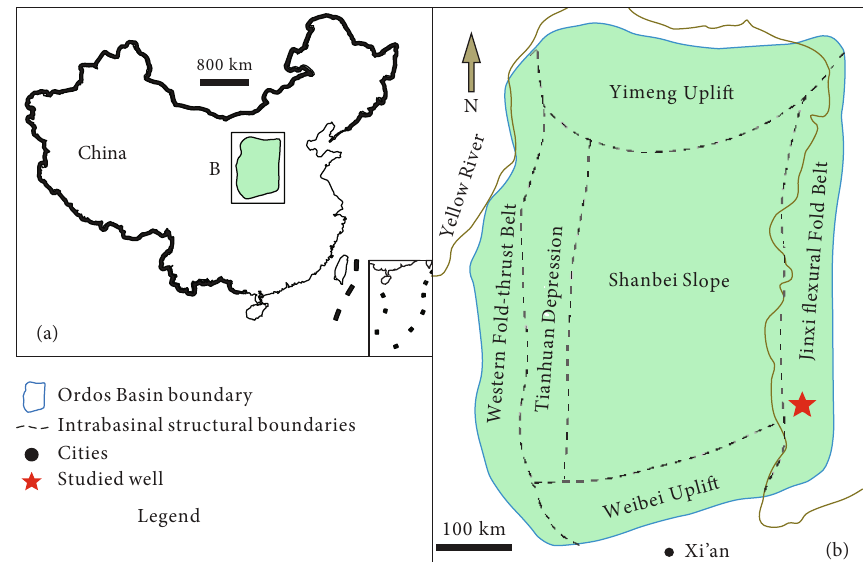
Figure 1: Location map of the study area in the Ordos Basin. The star shows the position of a well (DJ3-4) in the study area (modi fi ed after